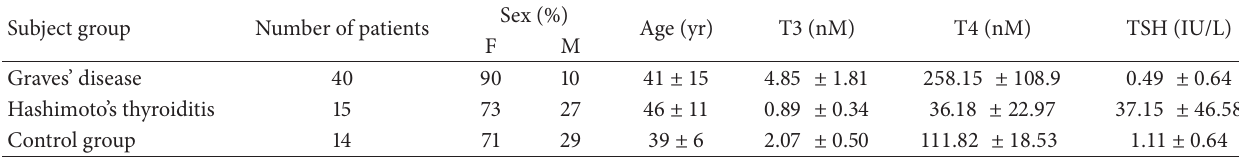
Table 1: Patients’ characteristics and thyroid parameters in various thyroid diseases.